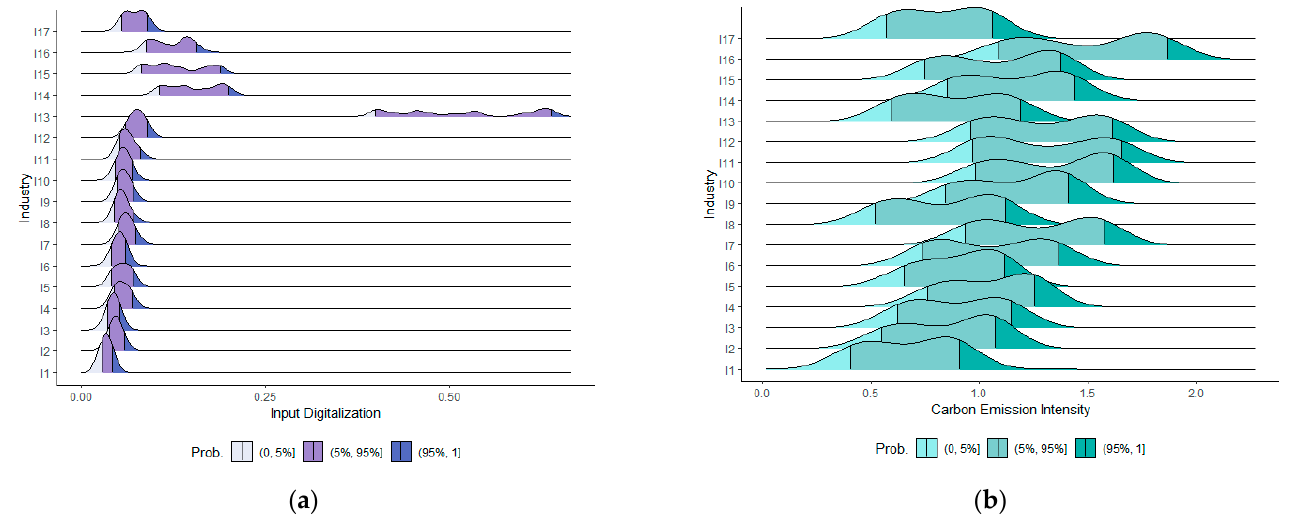
Figure 1. ( a ) Distributions of input digitalization. ( b ) Distributions of carbon emission intensity.